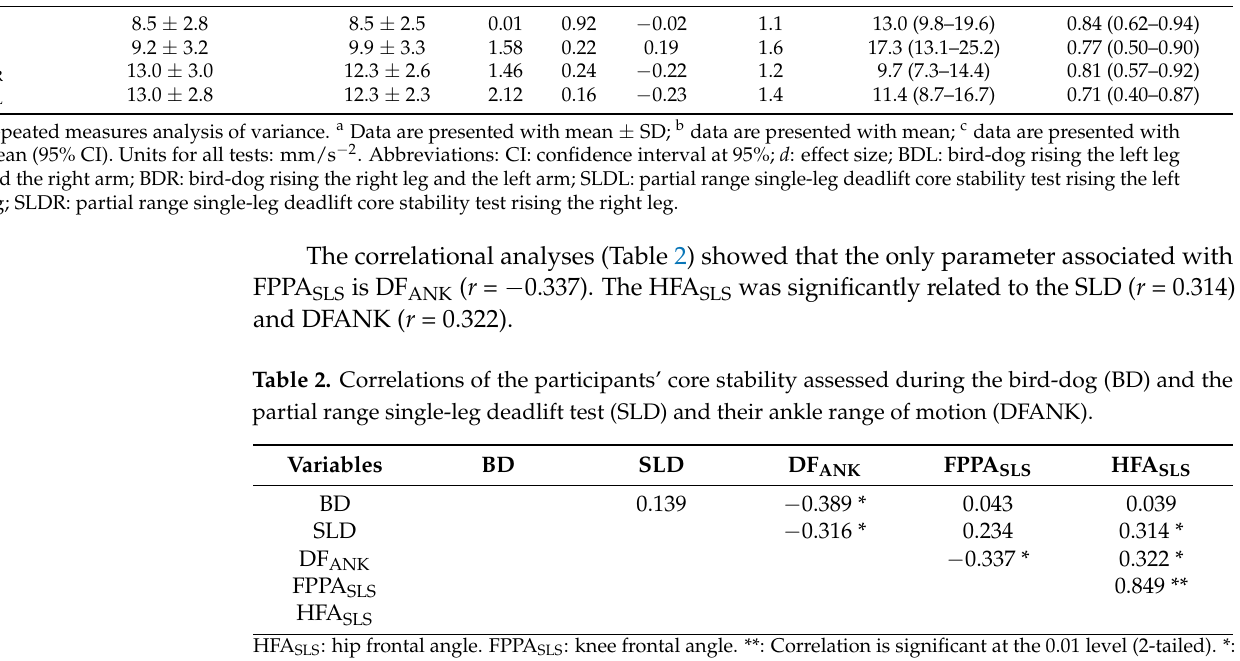
Table 1. Reliability scores for the bird-dog (BD) and the partial range single-leg deadlift core stability test (SLD) in healthy young women ( n = 20). Task Familiarisation Session a